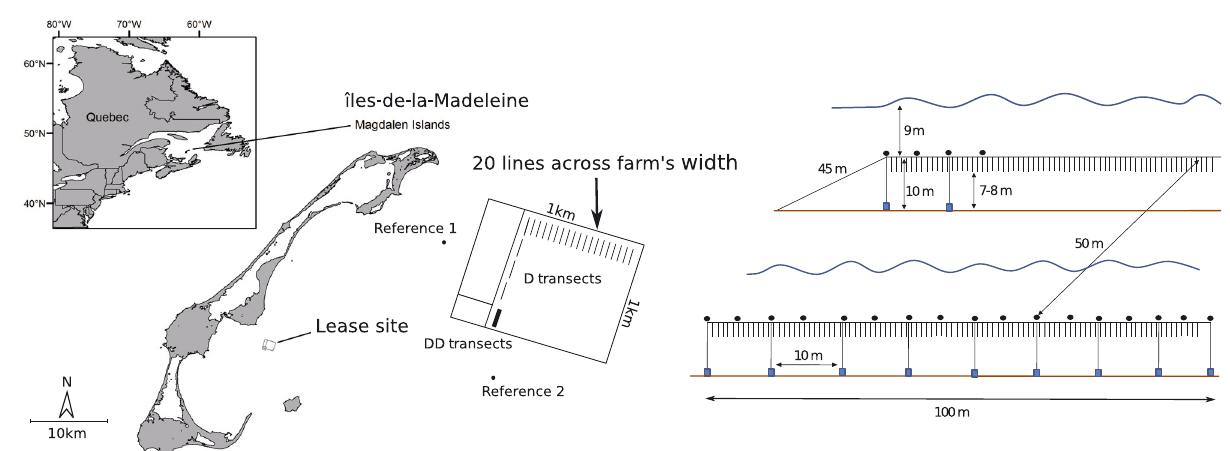
Fig. 1. Left: location of the study site. Transects were randomly positioned under 3 longlines of standard density (D transects) and 1 longline of double density (DD transects). Reference stations were positioned 500 m away from the lease site. Right: typical farm layout (modified from Guyondet et al.